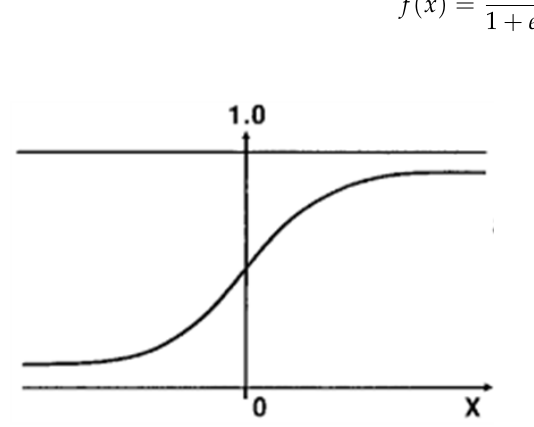
Figure 5. Sigmoid activation